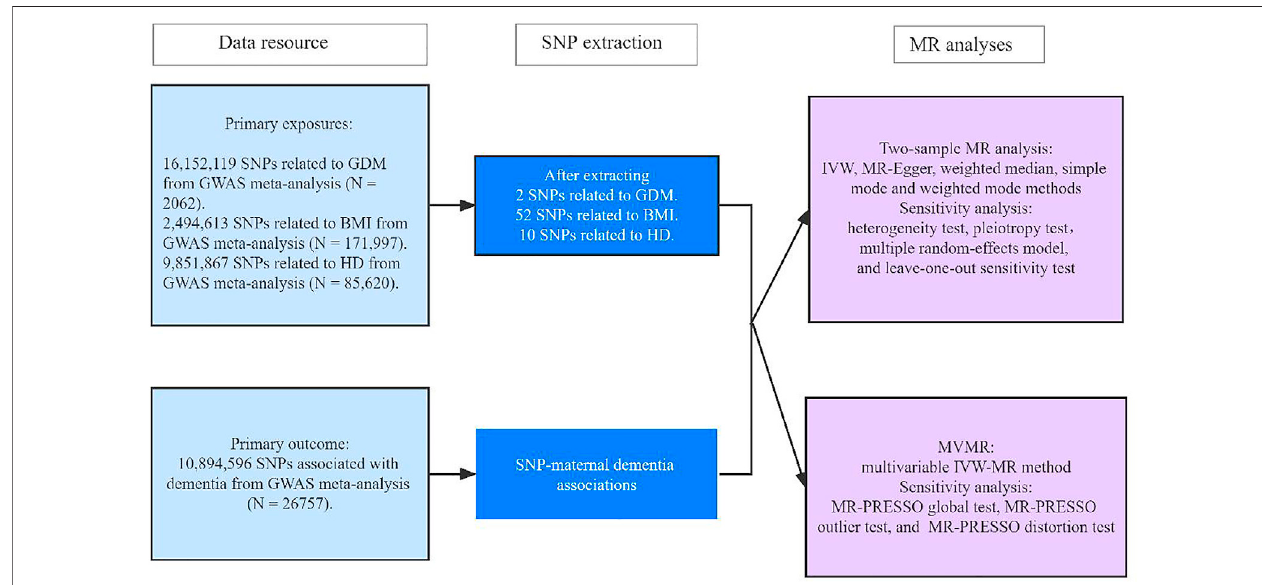
FIGURE 1 | Research framework. GDM, gestational diabetes mellitus; BMI, body mass index; HD, heart disease; GWAS, genome-wide association study; IVW, inverse-variance weighted; MR-PRESSO, pleiotropy residual sum and outlier.